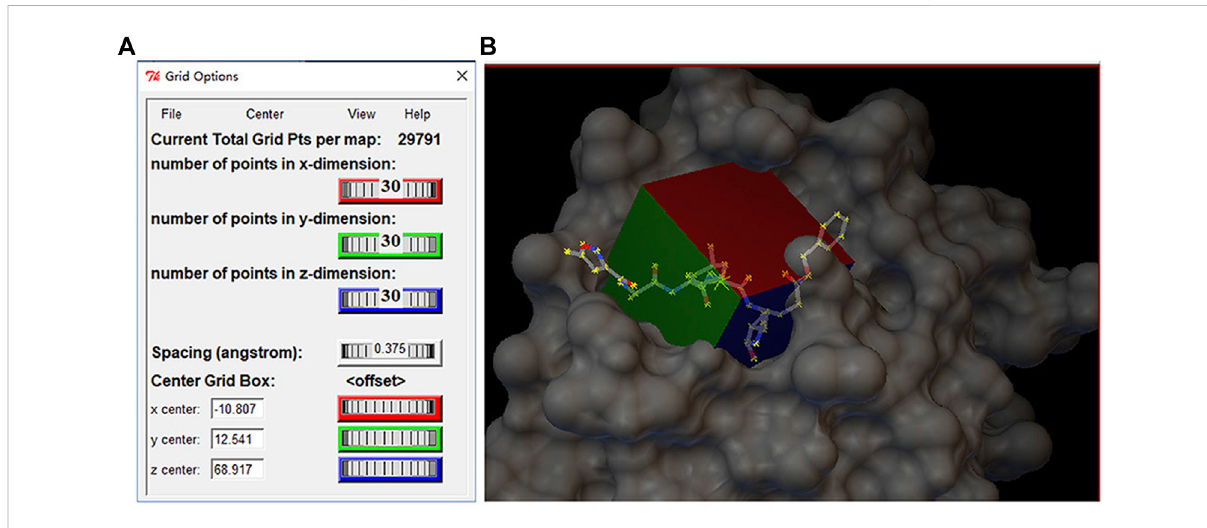
candidate drug molecule data set. Figure 3 shows the experimental process of molecular docking and virtual screening. Discovery Studio Visualizer was used to analyze the interactions and types of interactions between compounds and M pro (docking complexes).